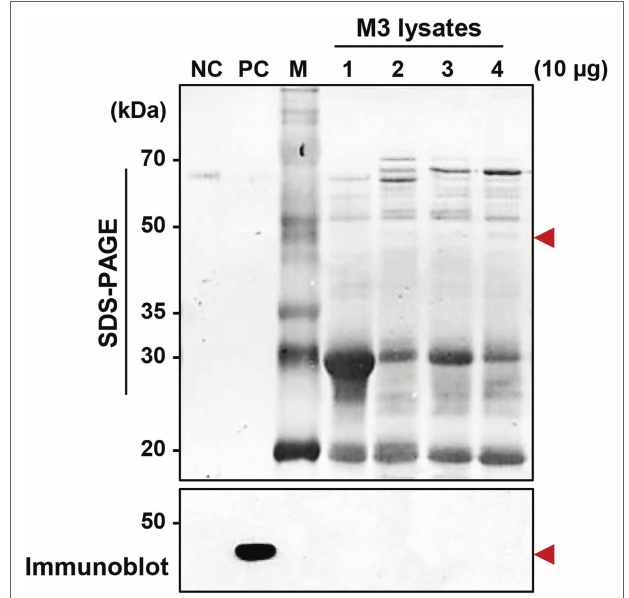
FIGURE 5 | Detection of serralysin in the M3 midgut region of Riptortus pedestris . Sodium dodecyl sulfate-polyacrylamide gel electrophoresis (SDS- PAGE; upper layer) and immunoblot (bottom layer) of M3 lysate after oral infection of male Sym insects with S. marcescens . Serratia marcescens cells (1.0 × 10 7 CFUs/ml) were orally infected into 3-day-old adult male R. pedestris insects. After infection for 48, 72, and 96 h, M3 tissues were collected from the insects, and the induction of serralysin was analyzed using specific antibodies. Arrowheads indicate the bands of purified serralysin. Negative control (NC): bovine serum albumin (BSA; 0.5 μ g); positive control (PC): purified serralysin (0.5 μ g); M: ladder marker. Columns 1, 2, 3, and 4 indicate the naïve M3, S. marcescens colonized-M3 (48 h post-inoculation (P.I.)), P.I. 72 h, and P.I. 96 h,